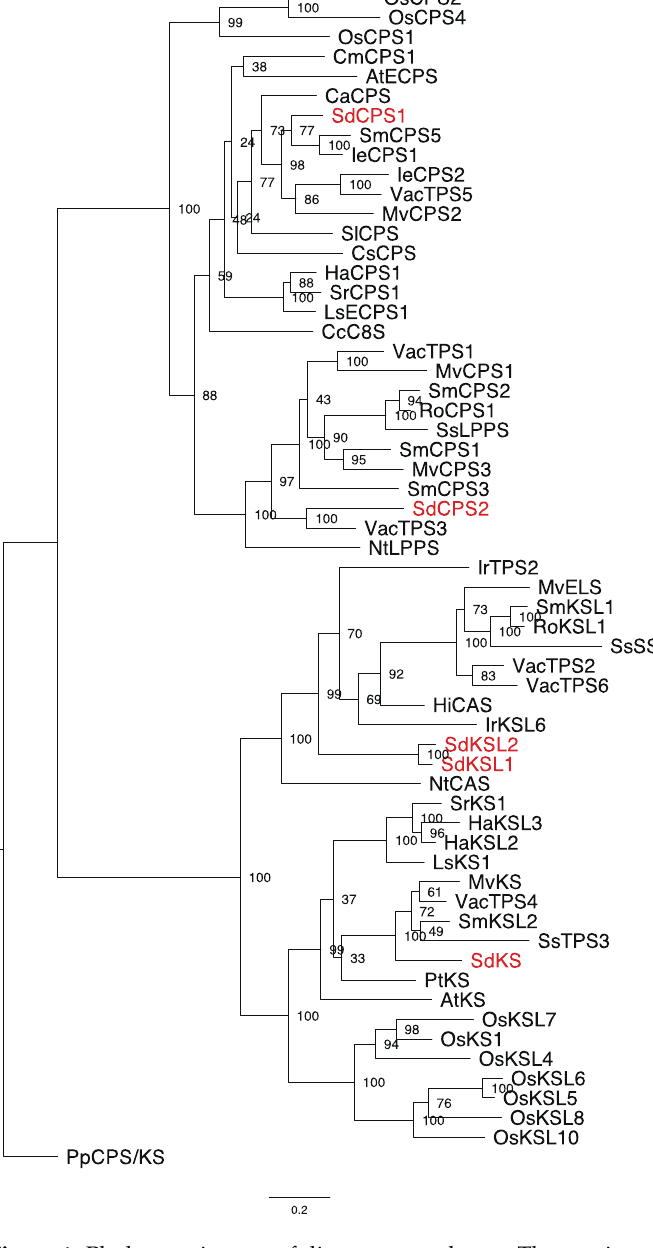
Figure 1. Phylogenetic trees of diterpene synthases. The maximum likelihood trees illustrates the phylogenetic relatedness of S. dulcis DTSs with other DTSs. The ancestral Physcomitrella patens ent - kaurene synthase (PpCPS/KS) was used to root the tree. Bootstrap values are displayed next to the nodes. Descriptions of DTSs used in the phylogeny are listed in Table